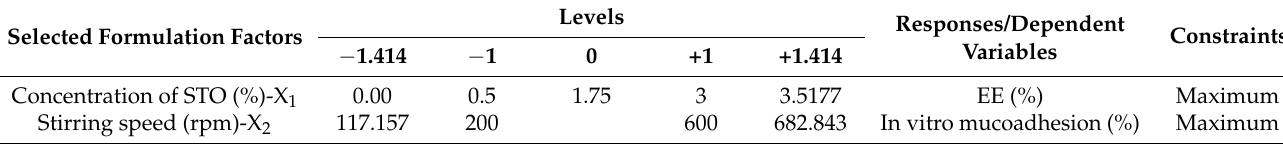
Table 7. Total work plan interns of coded and real values of selected parameters and constraints of dependent factors for central composite